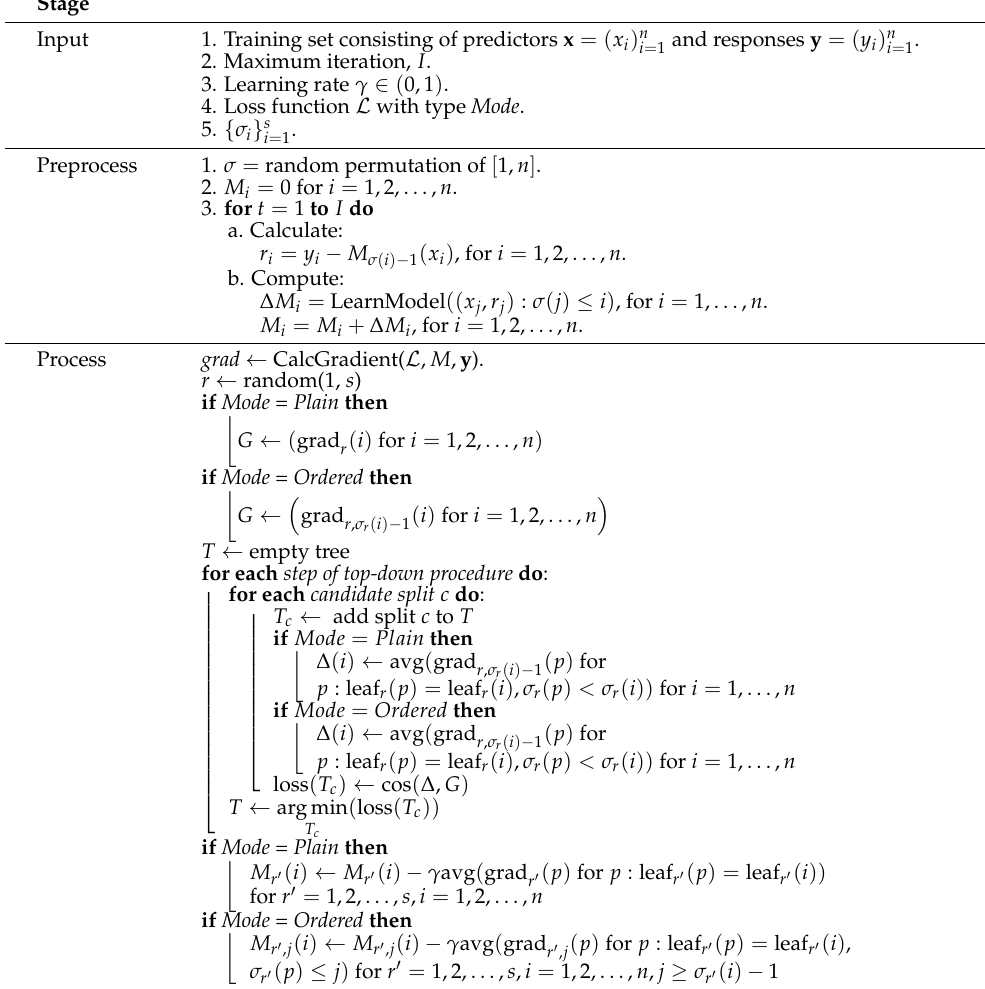
Table 3. CatBoost algorithm (Prokhorenkova et al.